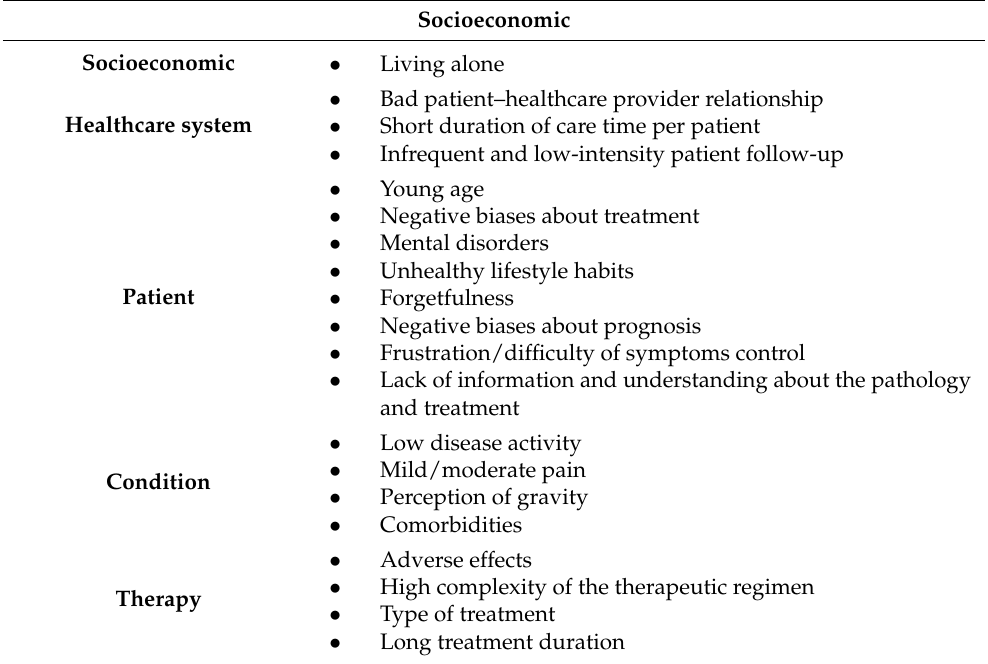
Table 4. Shared risk factors of non-adherence agreed by